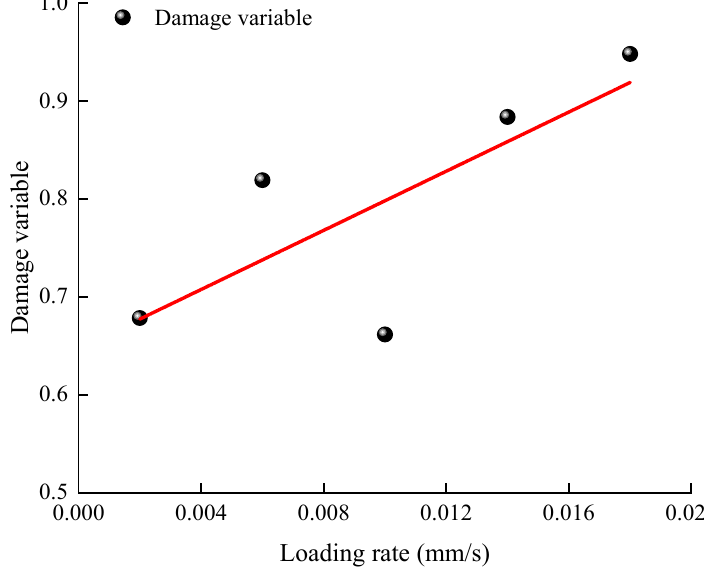
Figure 10. Relationship between damage variable at the peak stress and loading rate.